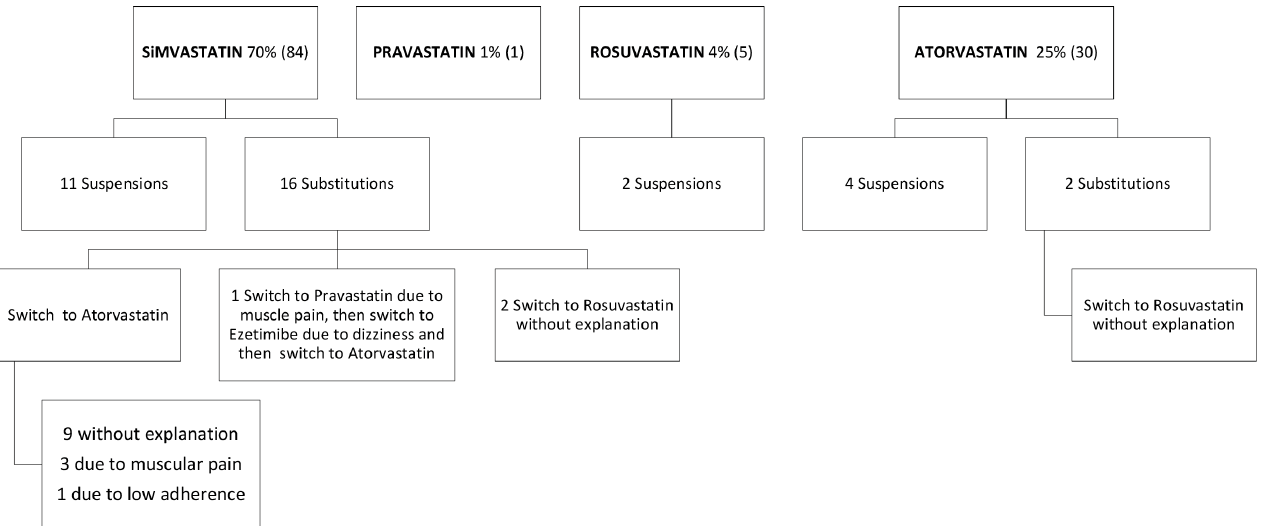
FIGURE 2 - Schematic diagram illustrating statin therapy suspensions and substitutions in dyslipidemic outpatients.